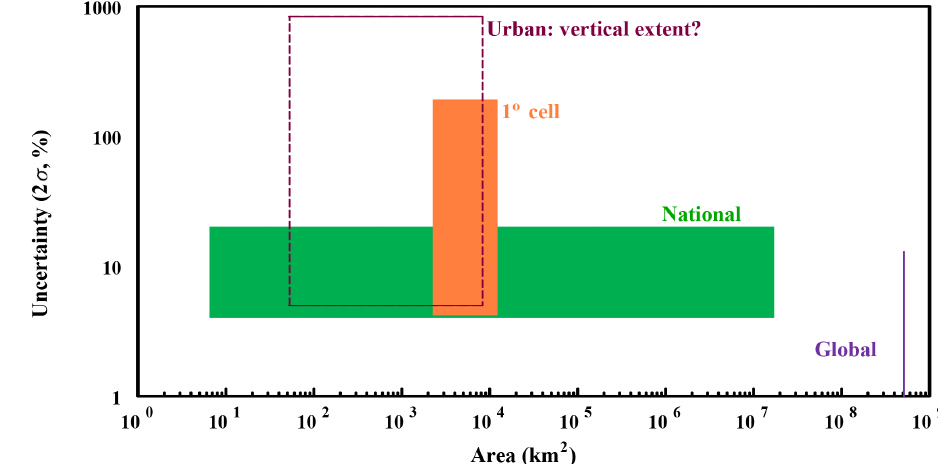
Figure 12. CDIAC experience regarding resolution and uncertainty. Here, the focus is on spatial resolution, but CDIAC also noticed a similar relationship in temporal scales going from annual to monthly to daily to hourly. The uncertainty on urban scale maps is largely unknown at